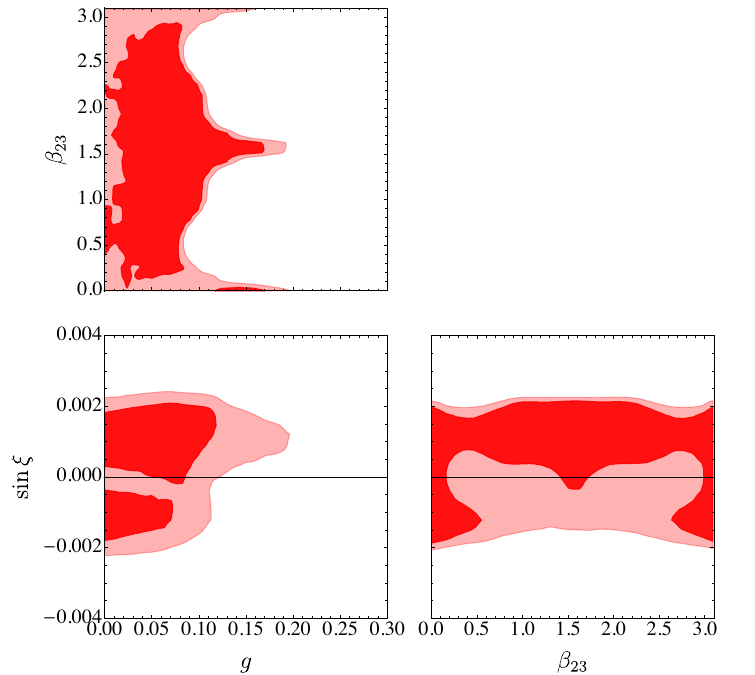
Figure 8. Correlations between ( g − 2) µ and A ( τ → µν ¯ ν ) NP / A ( τ → µν ¯ ν ) SM in the scenario with zero Z − Z 0 -mixing ( sin ξ = 0 ), where all Z 0 couplings to leptons are set to zero apart from g L,R The colored regions are preferred by the anomalous magnetic moment of the muon and by LFUV in tau decays, while the gray region is excluded by electroweak data for M for lighter Z 0 masses EW precision observables would be less constraining. The hatched region is excluded in this setup in the sense that points within it cannot be reached in this setup.